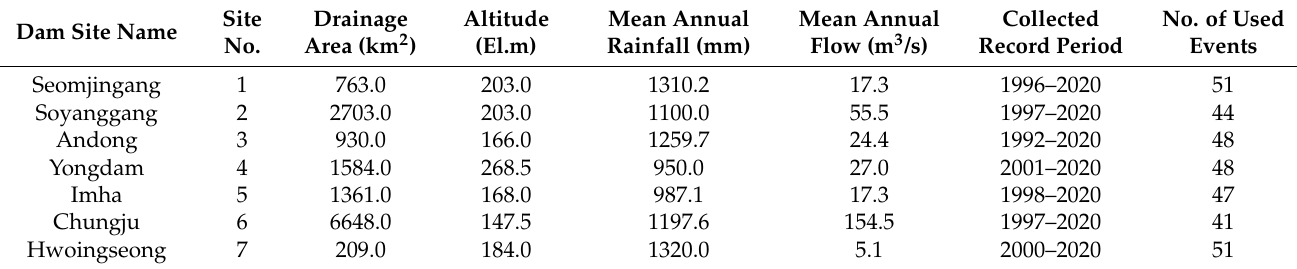
Figure 1. Location of the study sites. Table 1. Hydrological and geomorphological characteristics of the study sites.